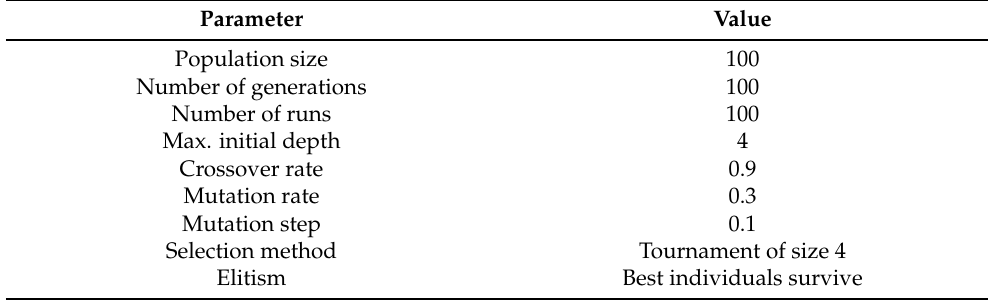
Table 2. Experimental